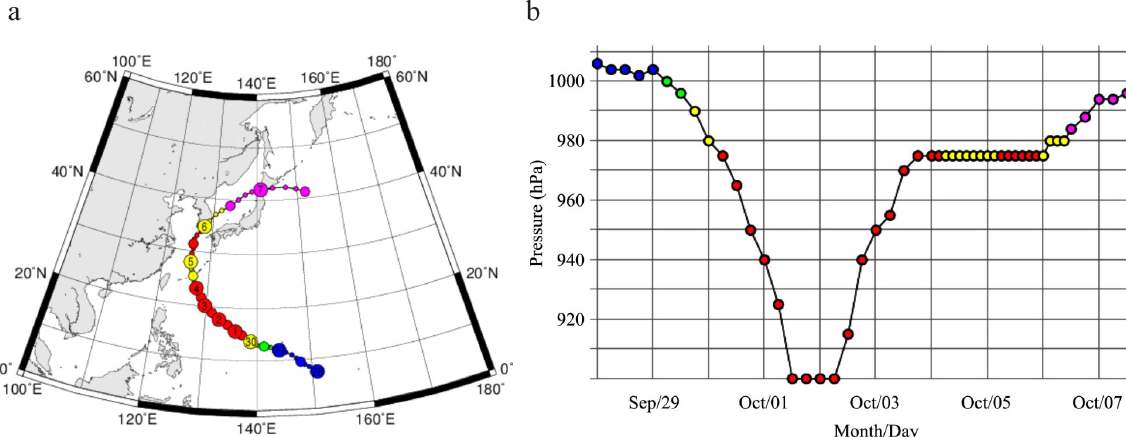
Figure 1. The (a) trajectory and (b) pressure of Typhoon Kong-rey (courtesy of Asanobu Kitamoto, Digital Typhoon, National Institute of Informatics, Japan).